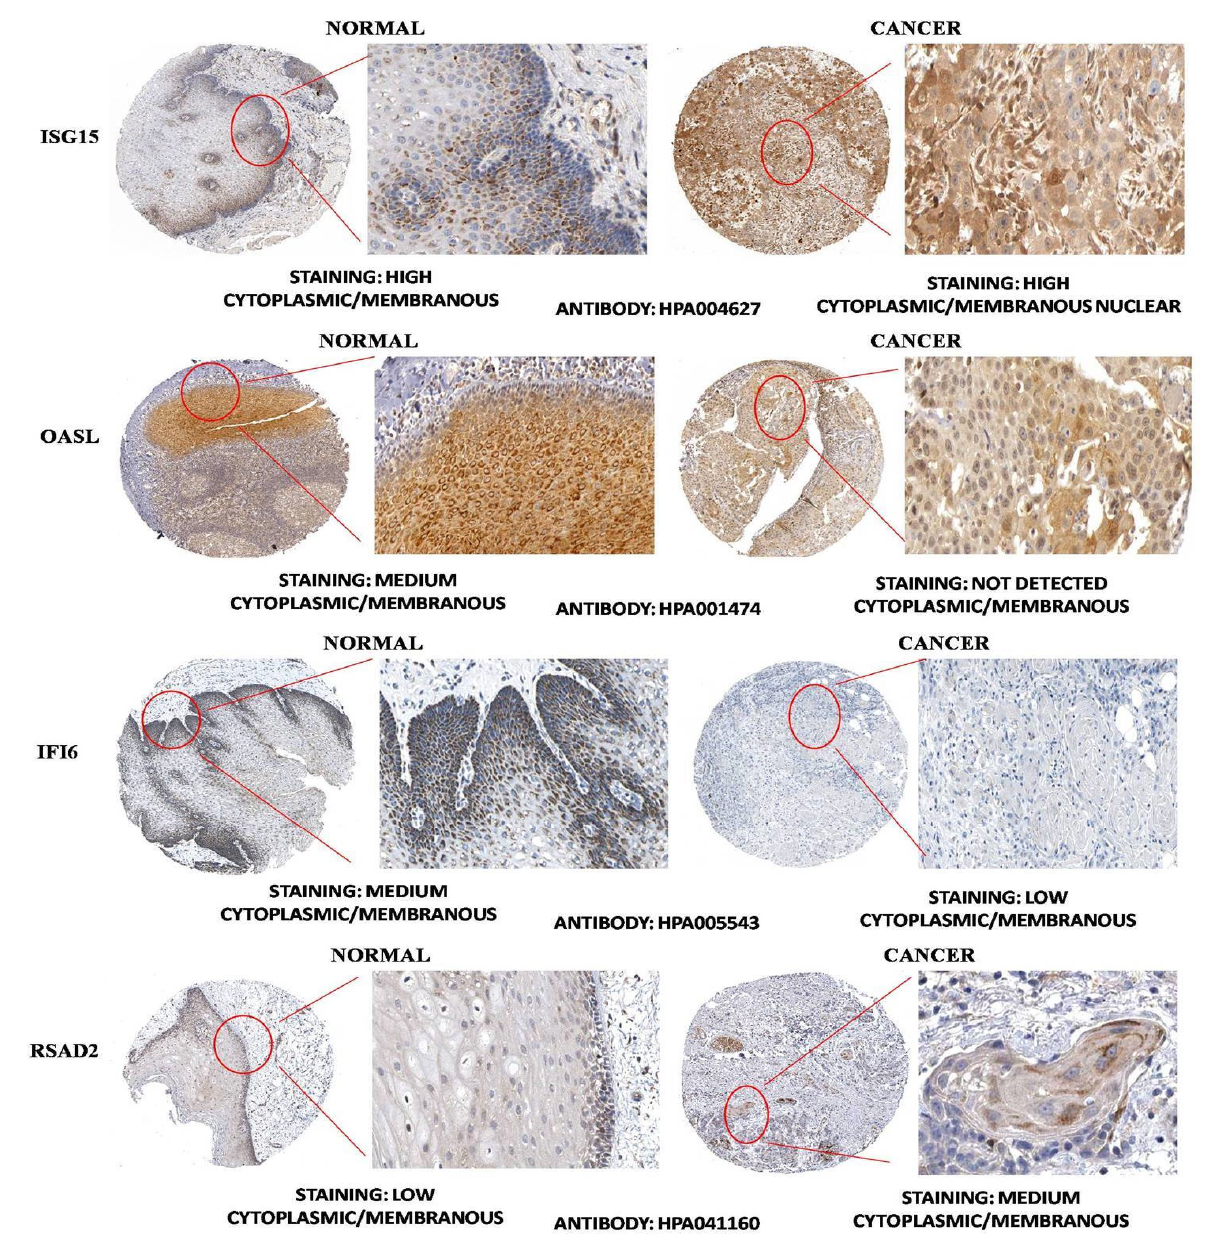
Figure 8. Representative immunohistochemistry images of ISG15, OASL, IFI6, and RSAD2 in normal head and neck tissues and head and neck squamous cell carcinoma (HNSC) tissues (Human Protein Atlas database).